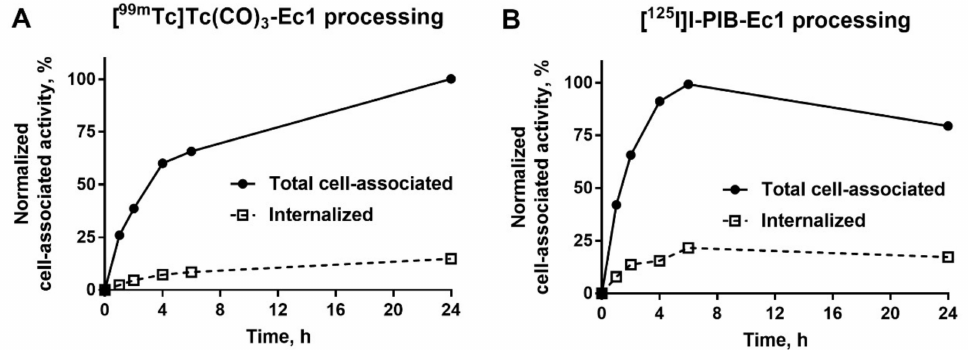
Figure 3. Cellular processing of [ 99m Tc]Tc(CO) 3 -Ec1 ( A ) and [ 125 I]I-PIB-Ec1 ( B ) by MDA-MB-468 cells during continuous incubation. Cells were incubated with the DARPins (1 nM) at 37 ◦ C. Data are presented as the mean of three samples ± standard deviation (SD). Error bars might not be seen when they are smaller than data point